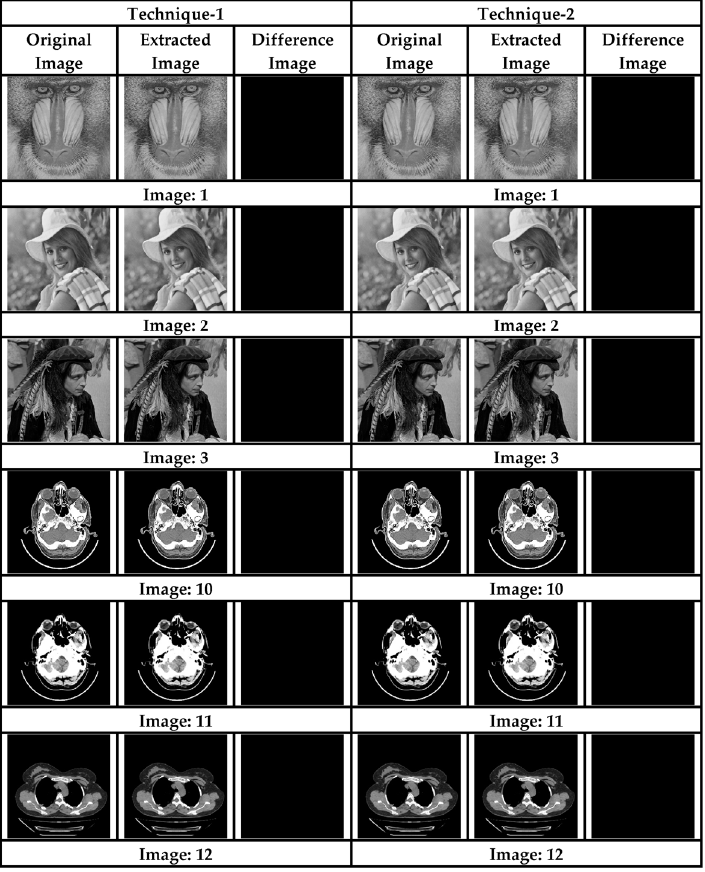
Figure 6. Subjective analysis for reversibility.